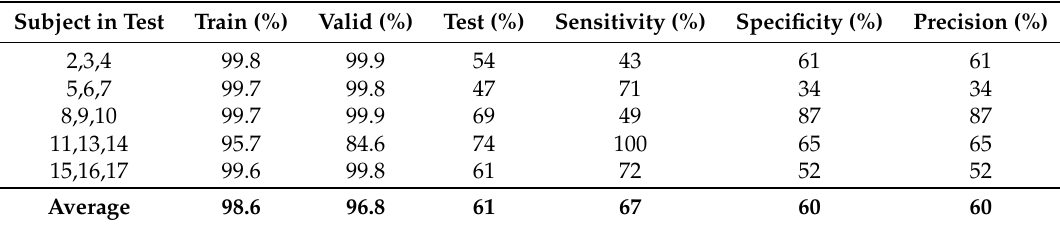
Table 6. The accuracy measures for the generic models using spatial domain images.